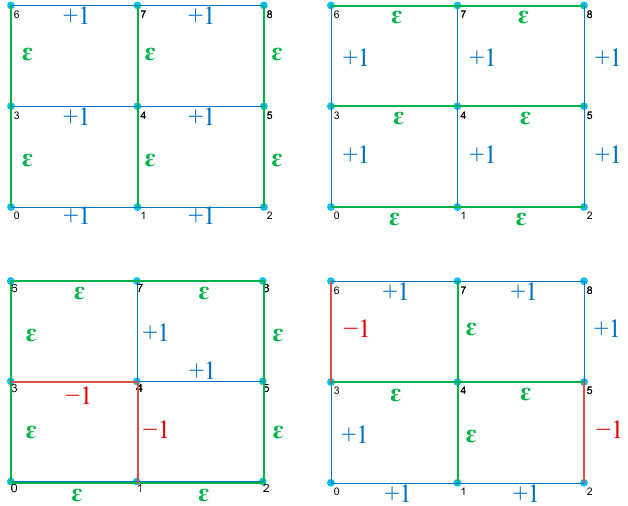
Figure 11. Statuses of dynamic voltage balancing.